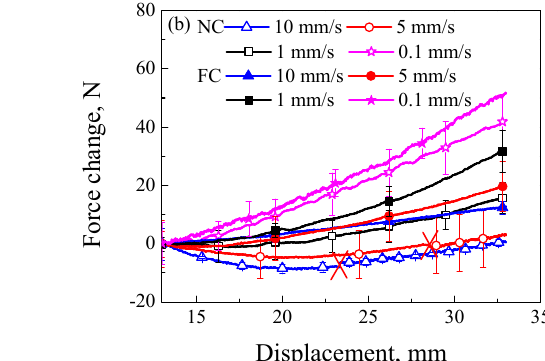
Figure 5. Illustration of loading partition. The strain contours of SMPU at different loading rates in the NC and FC conditions are given in Figure 6. (To enable the reader to observe more intuitively, three typical videos of strain localizations are presented in the Supplementary Materials.). The deformation process can be obtained directly according to five characteristic points shown in Figure 5. Overall, whether it is the NC condition or FC condition, the deformation presented an obvious strain localization, and the strain localization continued propagating with the increasing displacement. The initial position of strain localization nucleated near the transition section of the specimen. The difference in the propagation mode of strain localization could be observed at different loading rates. It was seen that the maximum strain increased with the increasing loading rate, i.e., 110.0% for 0.1 mm/s, 167.2% for 1 mm/s, 315.3% for 5 mm/s and 343.4% for 10 mm/s in the NC condition, 91.2% for 0.1 mm/s, 145.2% for 1 mm/s, 191.9% for 5 mm/s and 241.2% for 10 mm/s in the FC condition, respectively. The minimum strain decreased with the increasing loading rate, i.e., 76.8% for 0.1 mm/s, 13.4% for 1 mm/s, 5.7% for 5 mm/s and 4.9%